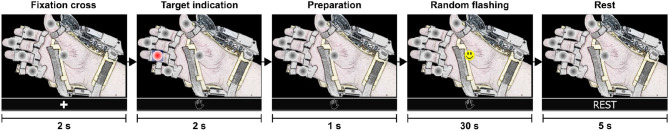
Steps of a single training sequence (training run). The complete calibration consists of eight runs and lasts 320 s. At the end of the calibration routine, the training dataset contains 264 epochs of the target class and 1,320 trials of the non-target class.